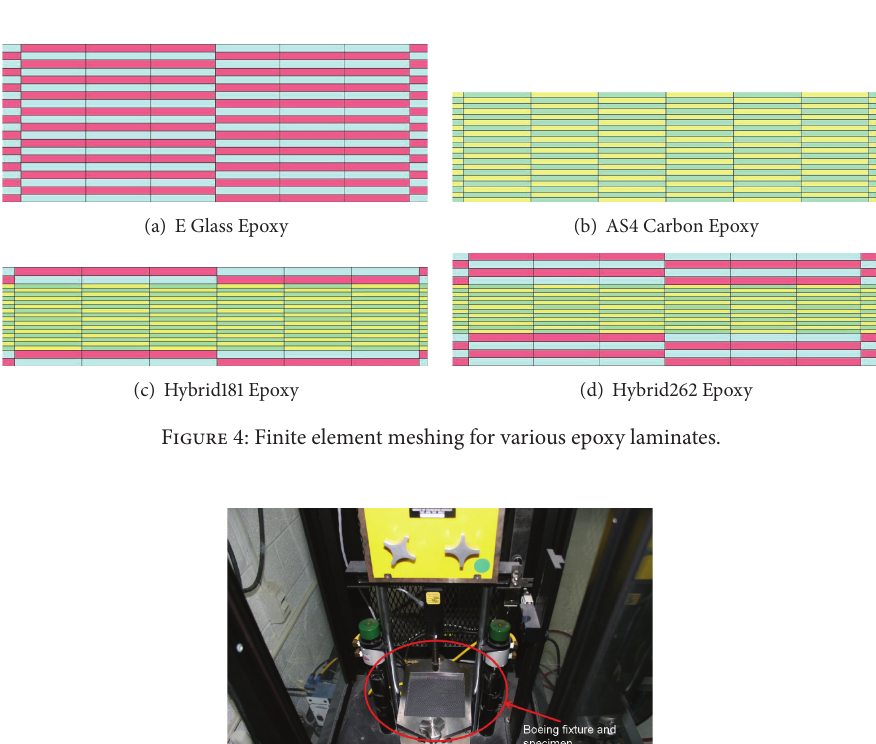
Figure 3: Equivalent mosaic model for E Glass Epoxy and AS4 Carbon laminates.